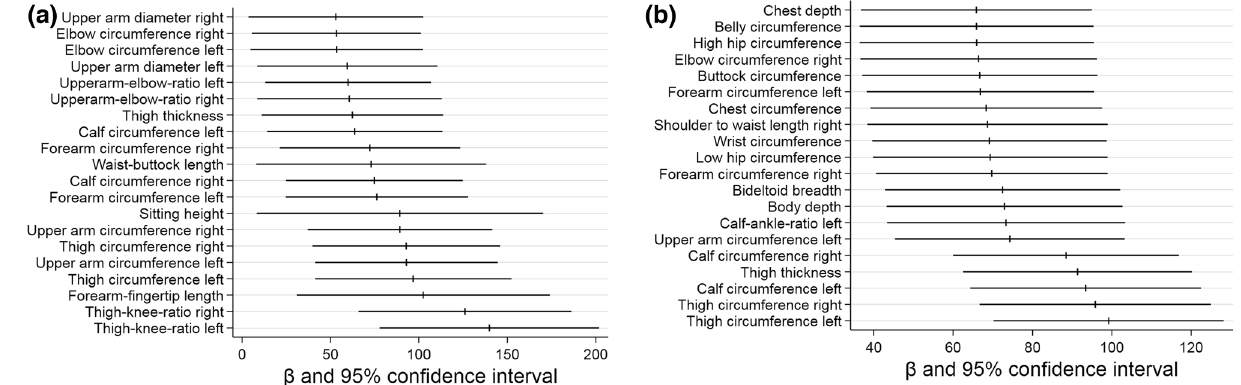
Figure 5. ( a ) Graphics of the strongest related body scan markers for VO2peak (ml/min) for male subjects; the strongest associations are displayed in the lower right; lines are expressed as β- and 95% confidence interval. ( b ) Graphics of the strongest related body scan markers for VO2peak (ml/min) for female subjects (graph below); strongest associations are displayed in the lower right; lines are expressed as β- and 95% confidence